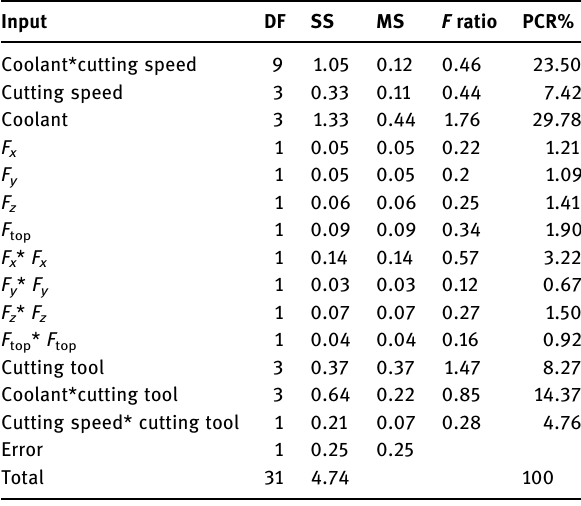
Table 5: ANOVA results for R